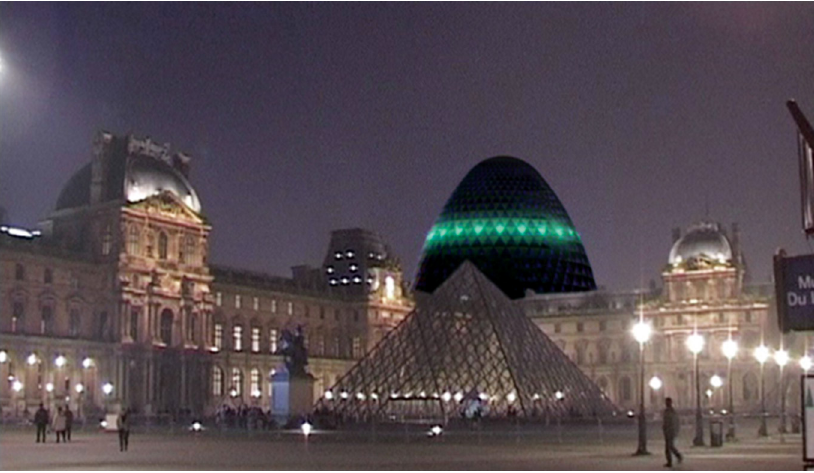
Figure 10. Outtake from an experimental project integrating André Bruyère’s “oeuf” into the Parisian landscape. Some associations can be drawn to Foster and Partners’ Swiss Re building in London. (Arnold, Jens. L’œuf de Pompidou. Video, 2003.